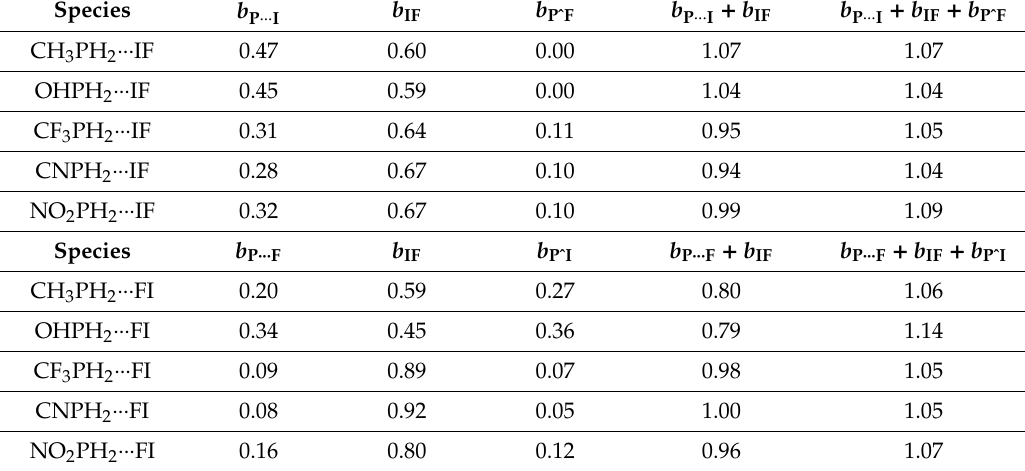
Table 8. Natural resonance theory (NRT) bond orders and bond order sums for the b P ··· I halogen bond, b IF covalent bond, and b PˆF long bond of RPH 2 ··· IF complexes (P ··· IF triad; upper rows) or the b P ··· F Note the near-constant “bond conservation” of the summed bond orders within each 3c / 4e triad